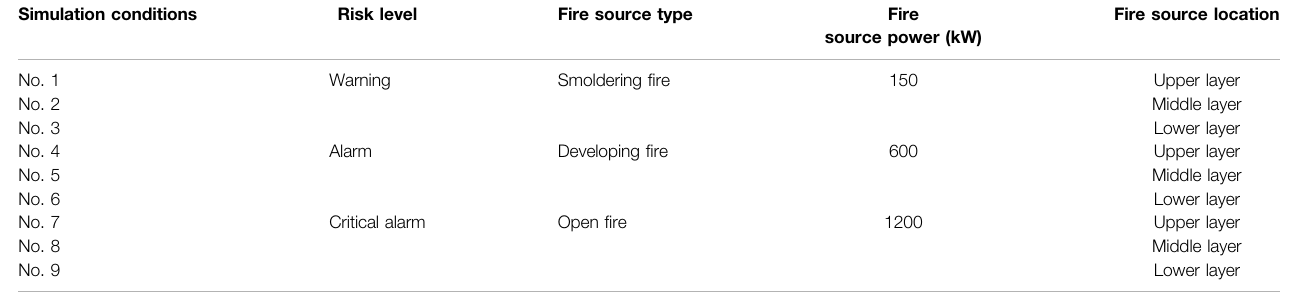
TABLE 3 | Fire simulation conditions of power cable tunnel.